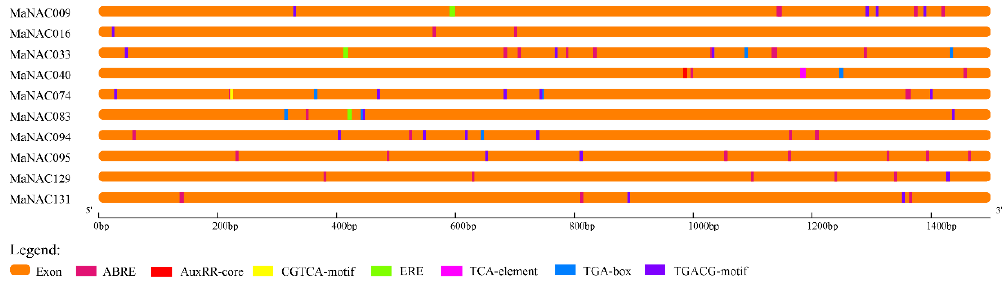
Figure 8. Cis -element analysis of 10 selected MaNAC genes from the upstream 1500 bp sequence to the transcription start site.